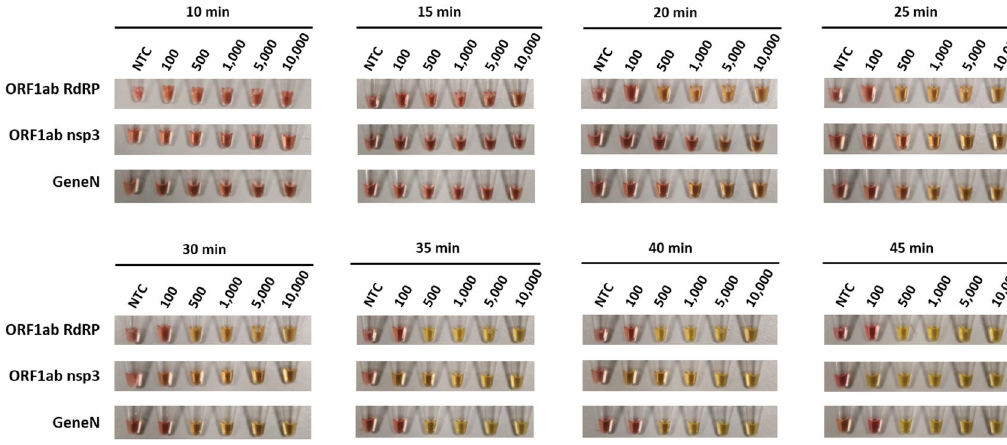
Figure 1. Colorimetric detection of SARS-CoV-2 DNA using LAMP. LAMP reactions are assessed at different time points using a dilution series of positive DNA control ranging from 100 copies to 10,000 copies. NTC (no template control) is used as a negative control. n = 3 biological repeats.